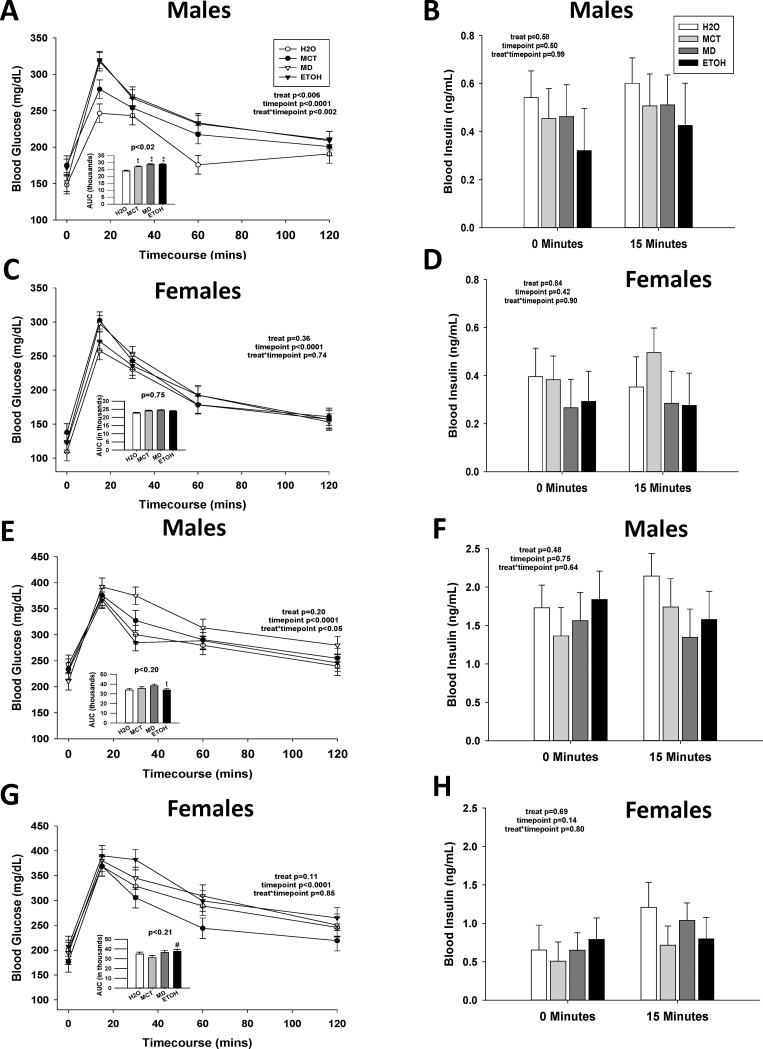
Prenatal calories, but not PAE, differentially impairs oral glucose tolerance in offspring.An oral glucose tolerance test (OGTT) was performed in 17-week-old PAE and control offspring (A-D), and again after they consumed a high-fat diet for four weeks. Blood glucose concentrations and insulin levels were assessed at times following an intragastric glucose bolus. (A) Male offspring receiving added gestational calories (MCT, MD, and ETOH) had higher blood glucose levels in response to oral glucose challenge as compared with H2O males. Males receiving PAE or isocaloric MD had significantly greater area-under-the-curve (AUC) values (inset) as compared with H2O-control males, and their AUC values did not differ from each other, suggesting that glucose clearance was reduced in those isocaloric groups. Males that received isocaloric MCT had a trend to elevated AUC compared with those that received H2O. (B) In these same males, PAE did not affect blood insulin levels as compared with H2O and isocaloric MD or MCT controls at either baseline fast or at 15 minutes post-glucose bolus. (C) PAE did not affect glucose clearance in female offspring as compared with H2O or isocaloric MD or MCT controls, nor did PAE alter the AUC for glucose clearance (inset). (D) PAE did not affect blood insulin levels in female offspring as compared with H2O and isocaloric controls at baseline fast and at fifteen minutes post-glucose bolus. (E) Consumption of a high-fat diet for four weeks elevated fasting blood glucose in PAE and control males. PAE did not further affect blood glucose or AUC values (inset) during the OGTT, as compared with controls. (F) In these males, high-fat diet consumption both elevated fasting insulin levels and their insulin levels at fifteen minutes post-glucose bolus. These levels were not further affected by PAE or prenatal treatment. (G) Consumption of a high-fat diet for four weeks elevated fasting blood glucose levels in PAE and control females. PAE did not further affect blood glucose or AUC values (inset) during the OGTT, as compared with controls. (H) In these same females, high-fat diet feeding elevated both fasting insulin and blood insulin levels at fifteen minutes post glucose bolus in all treatment groups. These values were not further affected by PAE or prenatal treatment. Values are mean ± SEM of 8–12 offspring per sex*treatment group. * p<0.05 vs. H2O, ** p < 0.01 vs. H2O, # p<0.05 vs. MCT, t p<0.1 vs. H2O, using mixed linear factorial analysis of variance, followed by slice-effect ANOVAs with a priori hypotheses allowing for planned comparisons.